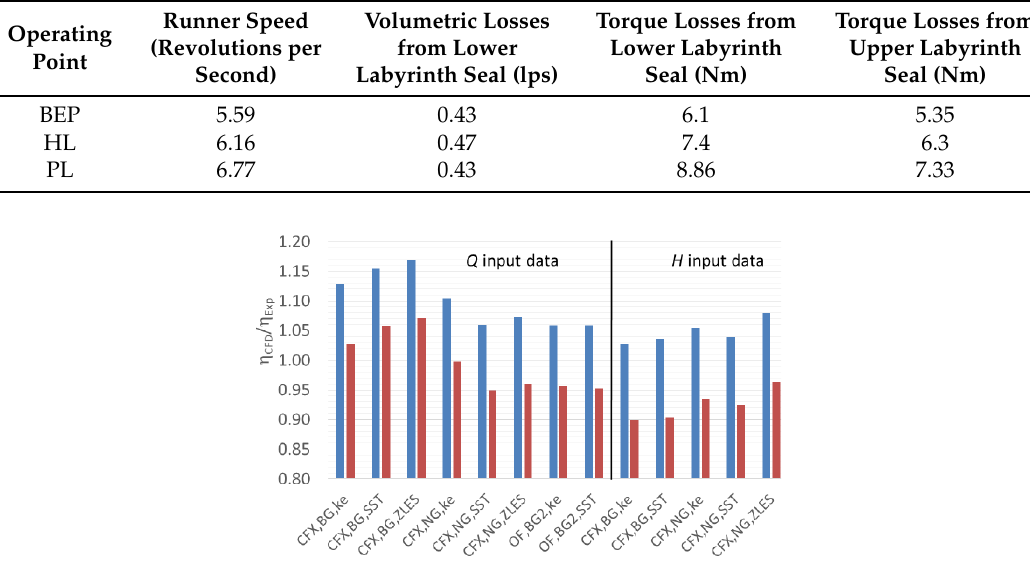
Table 5. Volumetric and torque losses from the labyrinth seals of the model Francis turbine under three operating conditions [11].